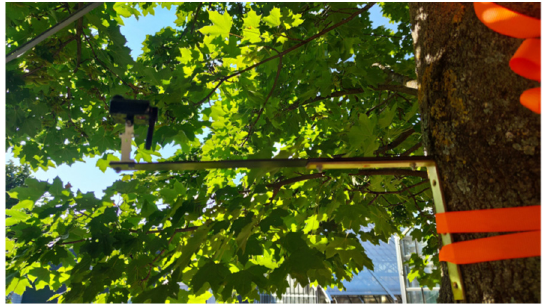
Figure 4. Sensor node B below the canopy of a Norway maple tree for executing continuous and automated LAI measurements.